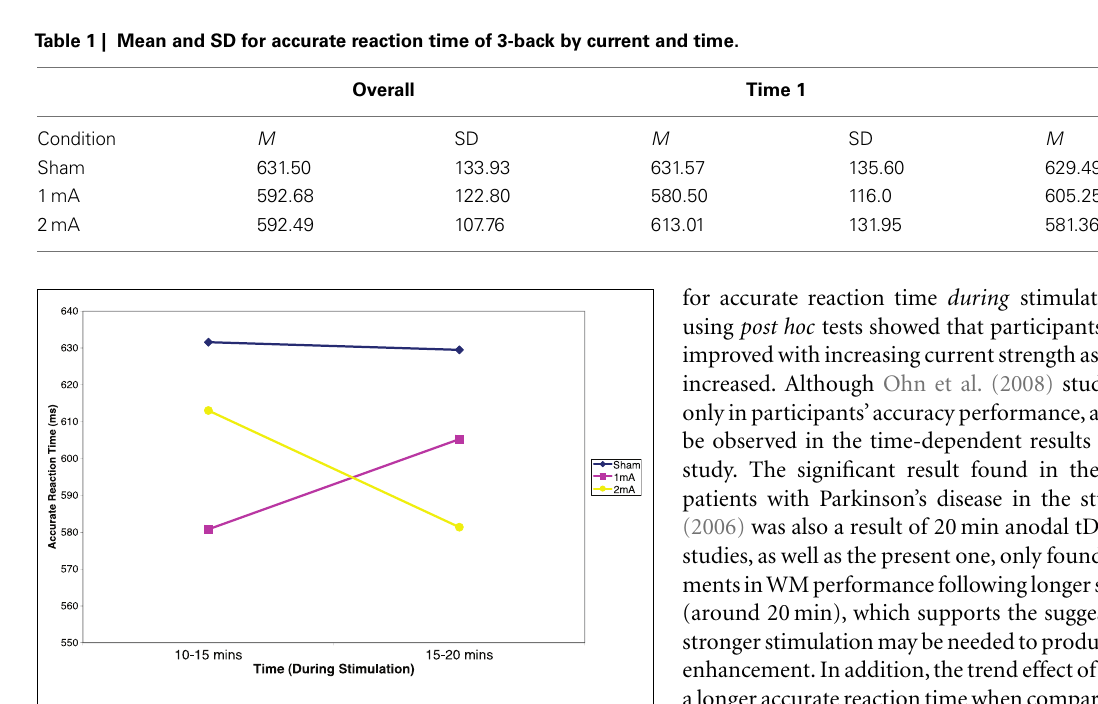
FIGURE 2 | Mean accurate reaction times interaction for the 3 back by current and